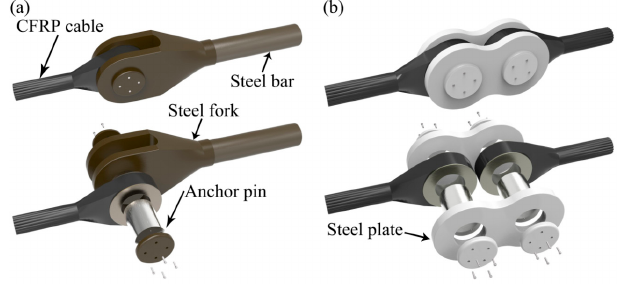
Figure 28. ( a ) Anchorage and ( b ) Connection for CFRP cables.